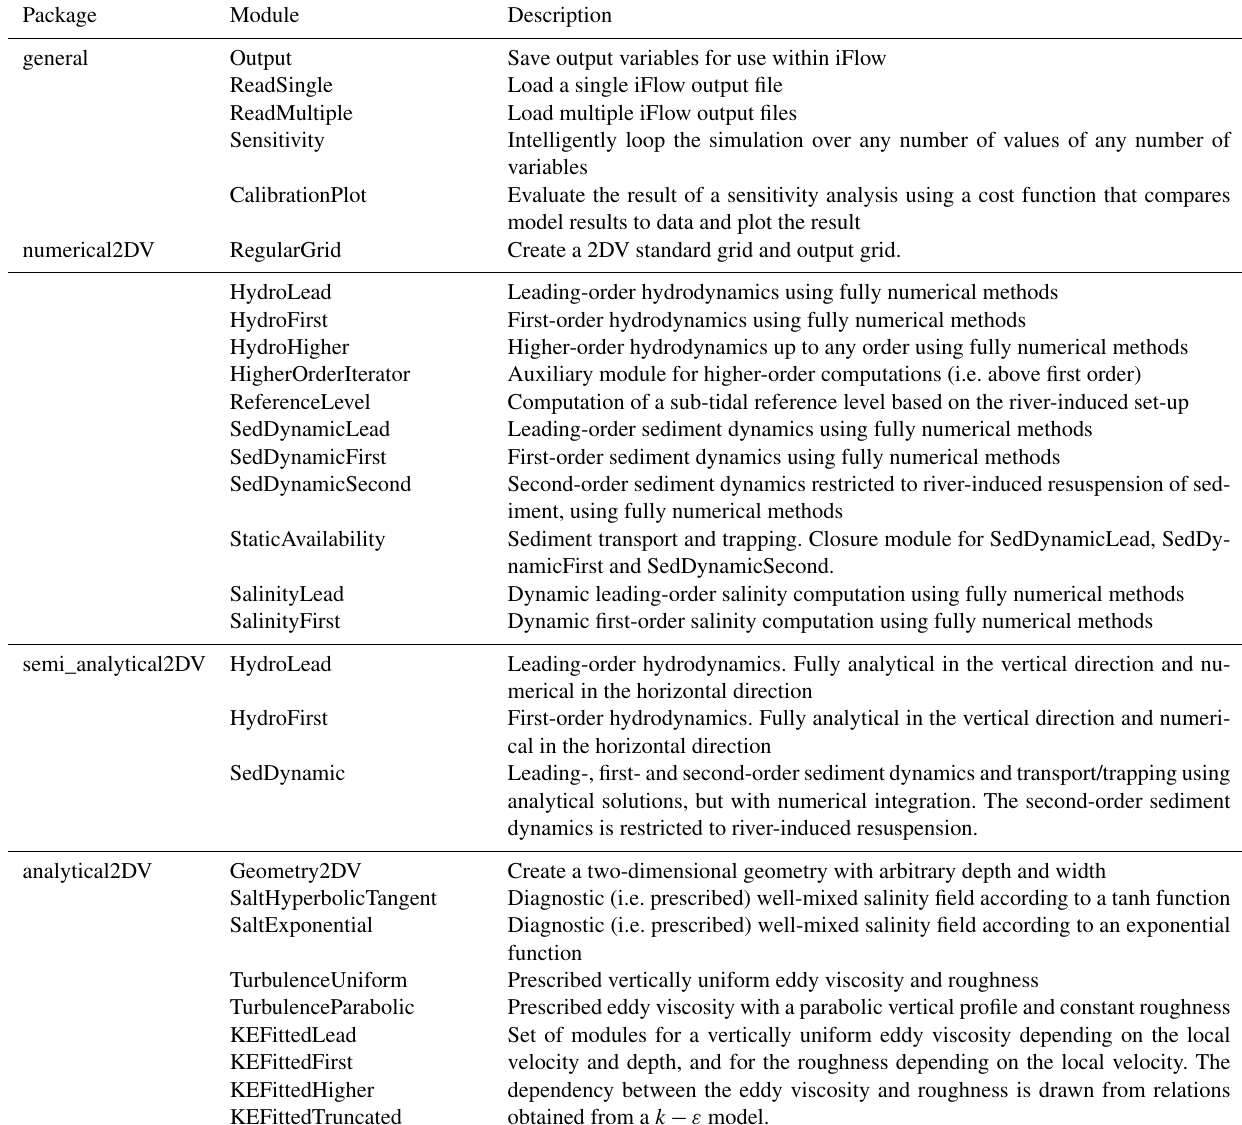
Figure 2. Model domain. The model is two-dimensional in the along-channel ( x ) and vertical ( z ) directions and is width-averaged. The depth and width are allowed to vary smoothly with x . Table 1. List of modules included in iFlow version